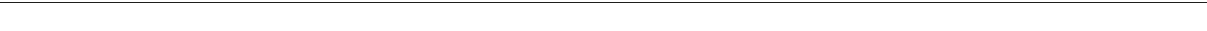
Fig. 1 Wg release is essential for the formation of lobula plate layers 3/4. a Schematic of the adult Drosophila visual system. Neurons in the lamina (L1/L2) and medulla (e.g., Mi1,4,9, Tm1 – 4,9) relay ON/OFF motion cues to T4 and T5 neuron dendrites in medulla layer (Me) 10 and lobula (Lo) layer 1. T4/T5 axons innervate lobula plate (Lop) layers 1 – 4. C&T neurons include C2/C3 and T2/T3 subtypes. b Schematic of the 3rd instar larval optic lobe. The OPC generates lamina (ln) and medulla (mn) neurons. p-IPC NE cells give rise to migratory progenitors that mature into d-IPC Nbs. These produce C&T and T4/T5 neurons. GMC ganglion mother cells, LPC lamina precursor cells. c Structure of wild-type wg and engineered wg loci ( wg{KO;NRT-wg} ). Open triangles indicate loxP sites. d R9B10-Gal4 UAS-cd8GFP (green) labels T4/T5 neurons. Connectin (red) marks Lop layers 3/4. d – g Neuropils were stained with nc82 (red) and aPKC (blue). Compared to controls ( e ), in wg{KO;NRT-wg} fl ies, one ( f ) or two ( g ) lobula plate layers were absent. h The decrease of layers correlates with T4/T5 neuron numbers. The scatter plot with bars shows data points and means with ±95% con fi dence interval error bars ( n = 15; three optical sections from fi ve samples per genotype). Unpaired, two-tailed Student ’ s t -test not assuming equal variance: P = 4.72 × 10 − 11 and P = 3.23 × 10 − 17 . **** P < 0.0001. Unlike in controls ( i ), Connectin was found in one ( j ) or none ( k ) of the Lop layers in wg{KO;NRT-wg} fl ies. Similar to nc82 ( f ), Connectin labeling showed gaps in the third lobula plate layer ( j ), potentially consisting of both layer 3 and 4 neurons. l – n In wild-type 3rd instar larvae (3L), the GPC areas (arrowheads), surface (s-)IPC (dashed line, double arrowheads), and a Nb clone (arrow) adjacent to the dorsal p-IPC subdomain (dashed line) express Wg (green). o Schematics of larval Wg expression (blue) in 3D and a horizontal section. Arrow indicates Nb lineage. For genotypes and sample numbers, see Supplementary Table 1. Scale bars, 50 μ